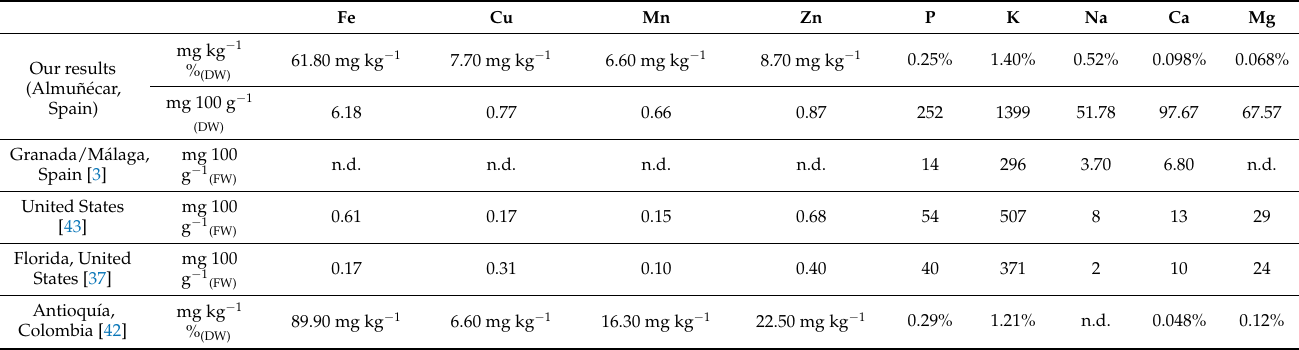
Table 2. Comparative table of the nutrient concentrations measured in the pulp of the avocado fruits in different studies. Values are expressed in mg 100 g − 1 , mg kg − 1 , and % (DW = dry weight, FW = fresh weight, n.d. = no